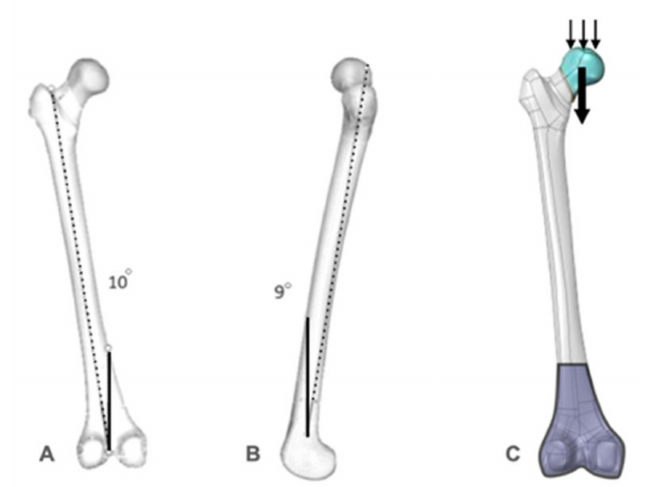
Figure 4. ( A , B ) Model of the virtual femur representing the inclination used in the tests; ( C ) the conditions and contours used during the test: load application area (blue with small arrows), load direction (larger arrow) and attachment area (purple).